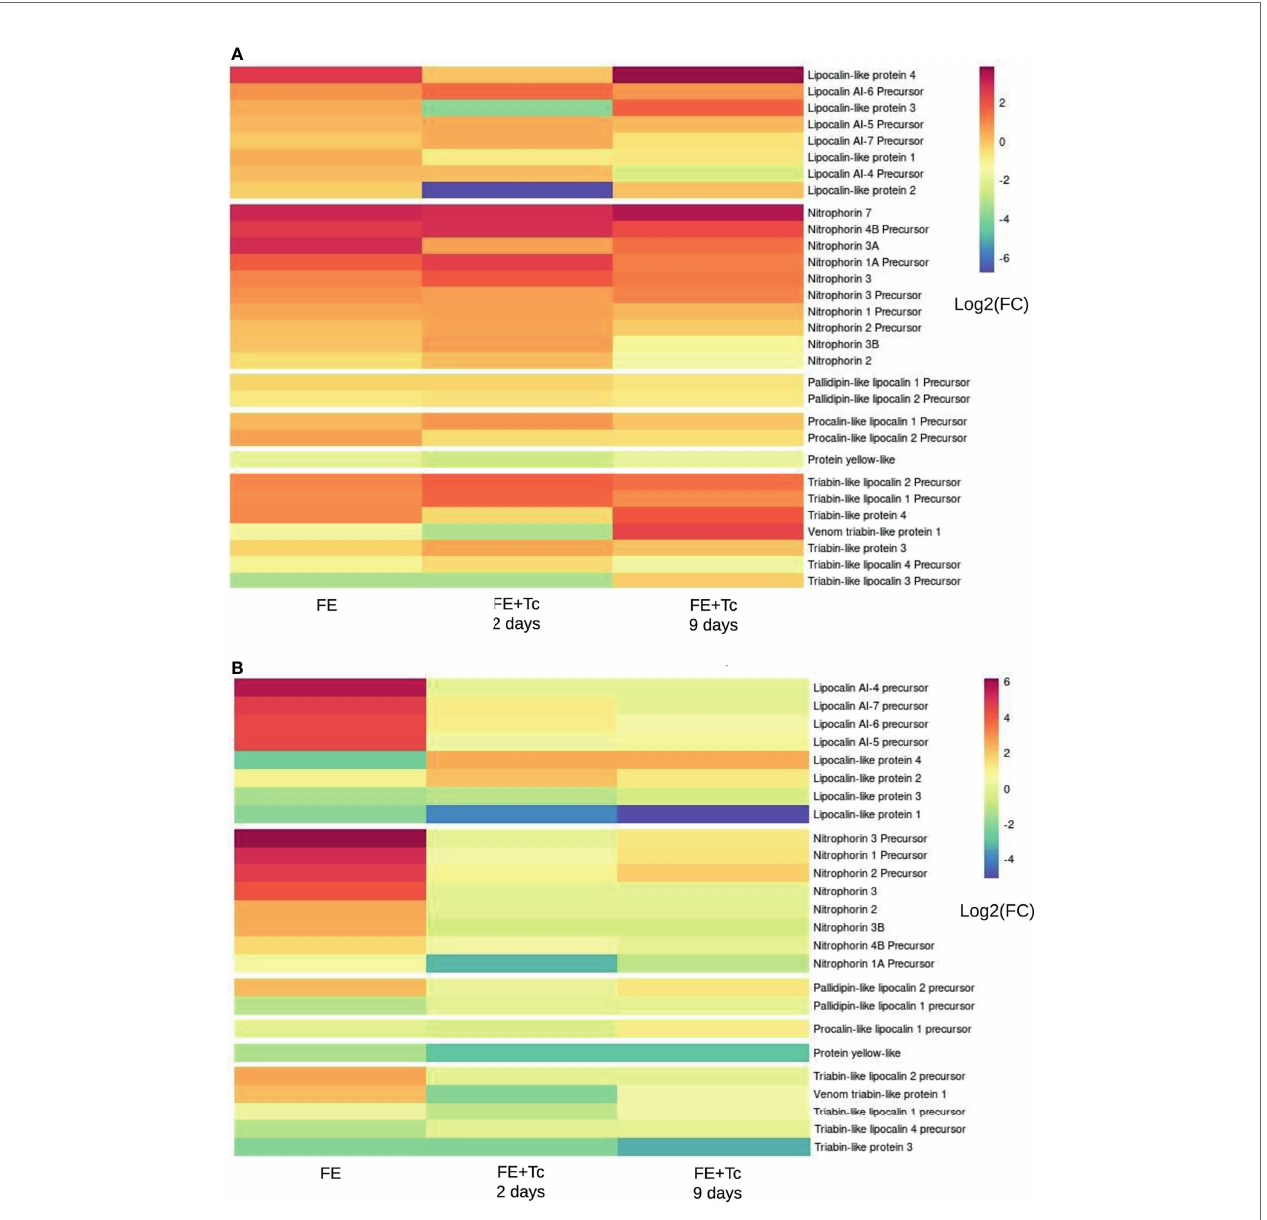
FIGURE 11 | Transcripts translatable into lipocalins, nitrophorins, and derivatives. (A) Differential expression of individual transcripts according to the blood supply and infection by T. cruzi in the salivary gland of the insect in relation to prolonged fasting. (B) Differential expression of individual transcripts according to blood feeding and T. cruzi infection in the insect ’ s intestine in relation to prolonged fasting. *FC, fold